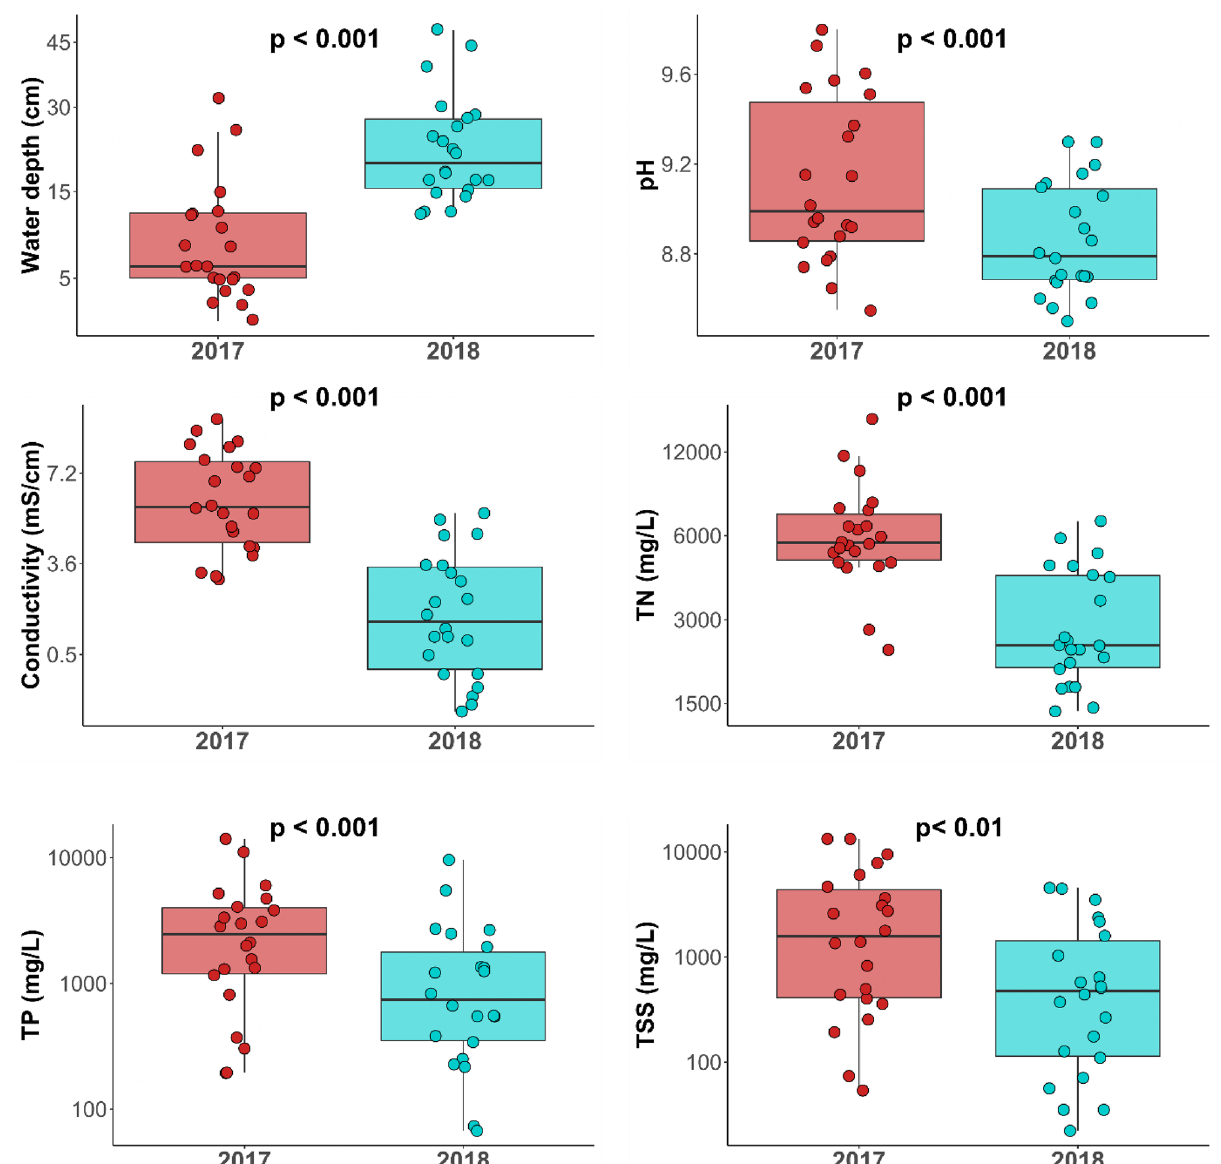
Figure 2. Boxplots illustrating differences in the environmental variables between the two sampling years. P values indicate significant differences between years based on paired t